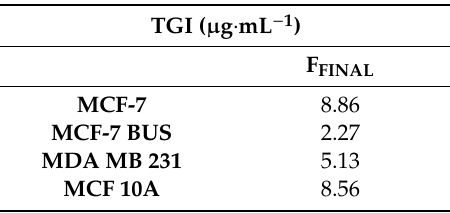
Table 4. Anti-proliferative activity of F FINAL against four human breast cancer cell lines and one no tumor